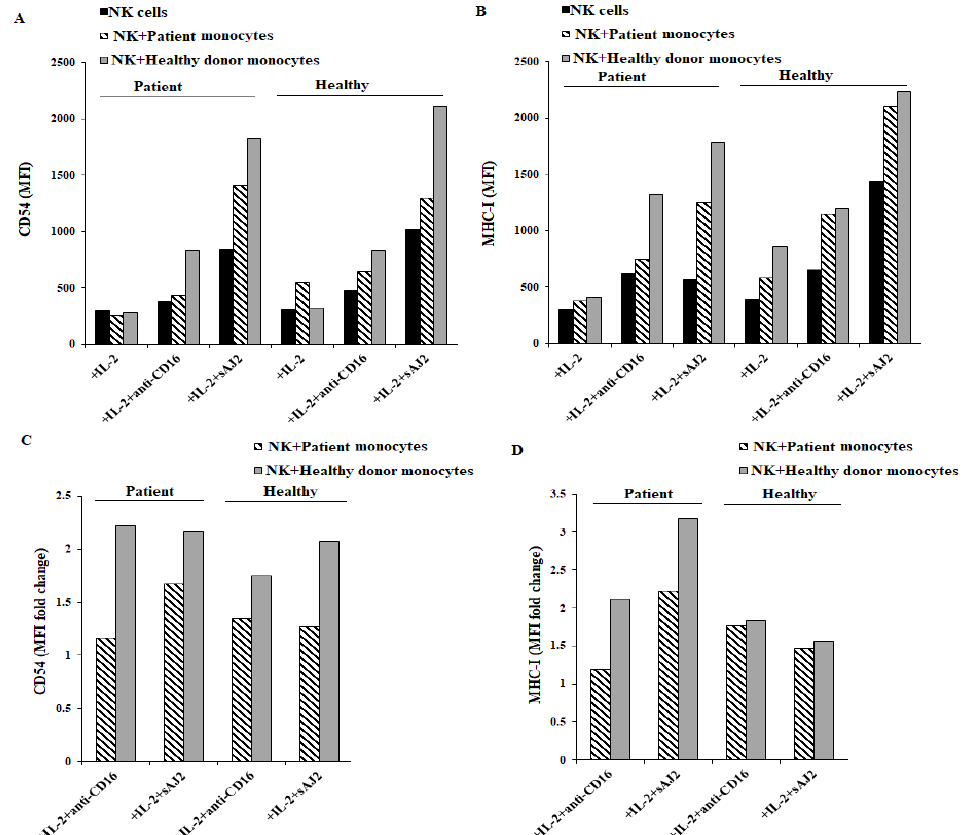
Figure 5. Supernatants harvested from autologous cancer patients’ NK and monocytes coculture treated with IL-2 + sAJ2 induced higher differentiation of oral squamous carcinoma stem cells (OSCSCs) in comparison to those treated with IL-2 alone or IL-2 + anti-CD16 mAbs. OSCSCs differentiation assay were conducted as described in Section 2 using supernatants collected from NK cell and monocyte coculture experiment. Surface expression of CD54 ( A ) and MHC-class I ( B ) on supernatant treated OSCSCs were determined using flow cytometry. MFI are shown in figures ( A – B ). MFI ratio of (Nk+monocyte/NK) for CD54 ( C ) and MHC-class I ( D ) surface expression were determined after treatment of tumor cells with supernatants collected from IL-2 + anti-CD16 mAbs or IL-2 + sAJ2-treated cells. One of two representative experiments is shown in this figure.